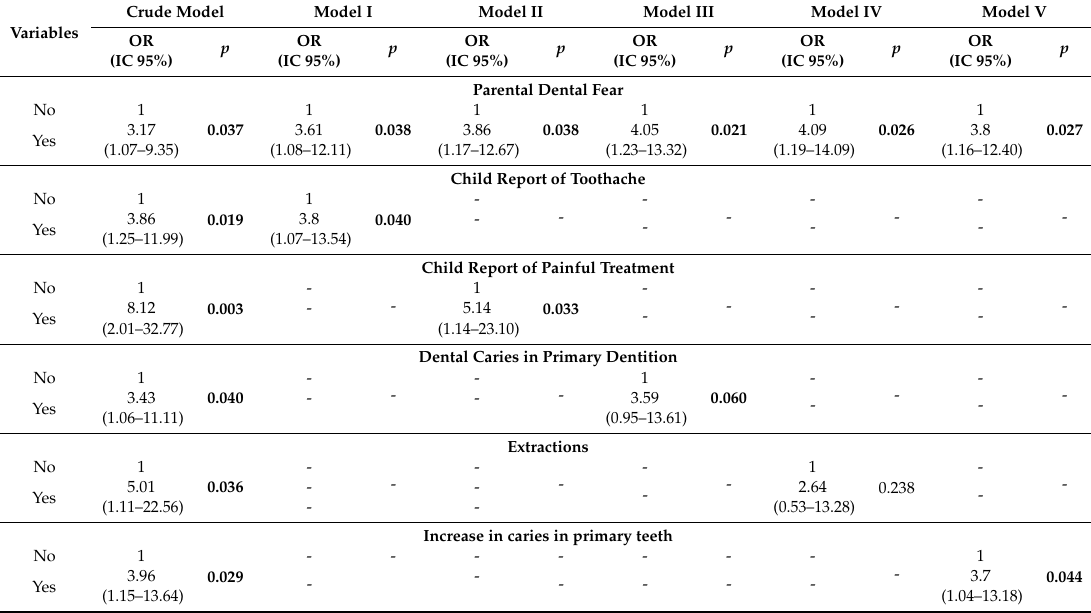
Table 3. Multilevel logistic regression for the incidence of dental fear and